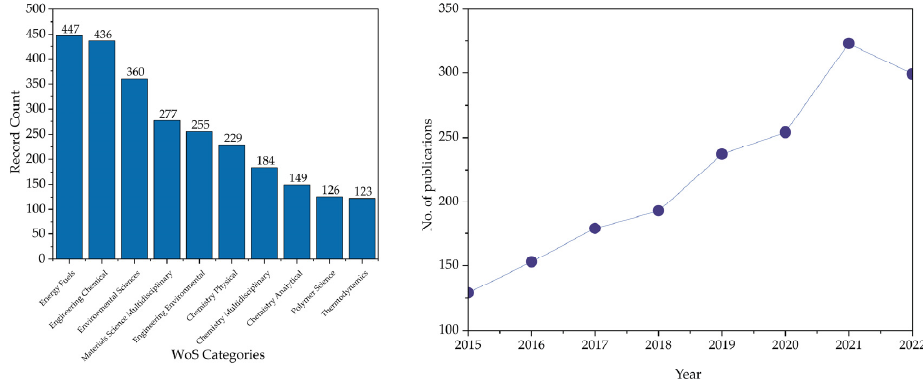
Figure 2. The top ten publishing categories and publications per year.